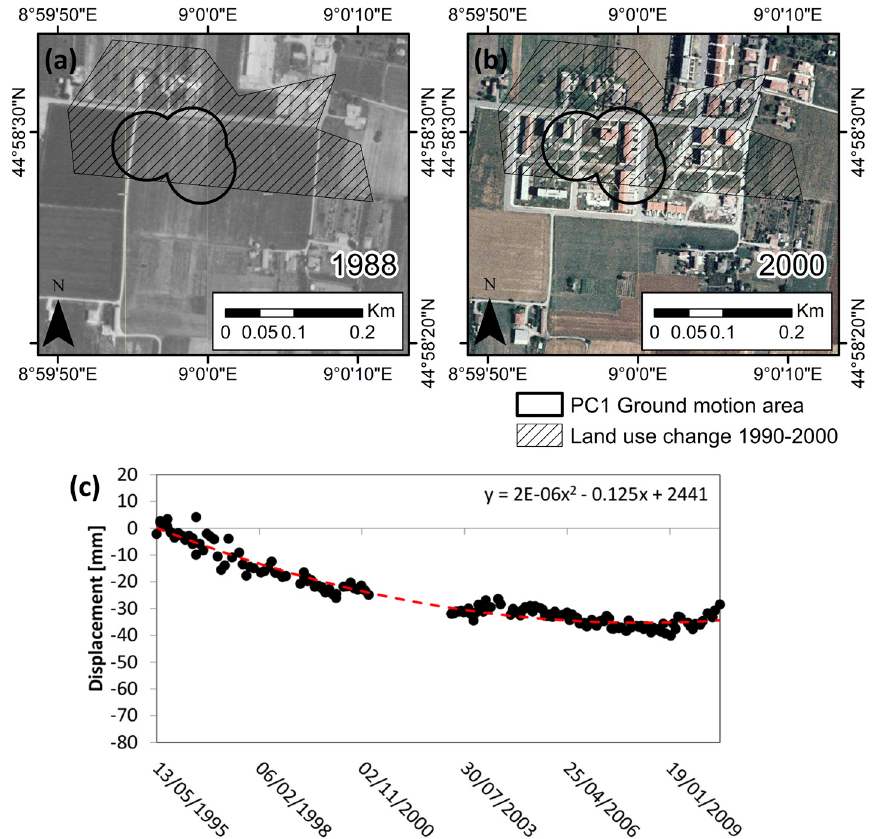
Figure 11. Location of the representative ground motion area detected using PC1 of the ERS-1/2 sensors in Voghera, superimposed on the land use change from 1990–2000, and on the Ortophotos acquired from 1988 ( a ) and 2000 ( b ). ( c ) Average displacement time series detected in the ground motion area. The dotted red line is the polynomial regression trend (2° order) of the displacement time series. The equation for polynomial regression has been also indicated.